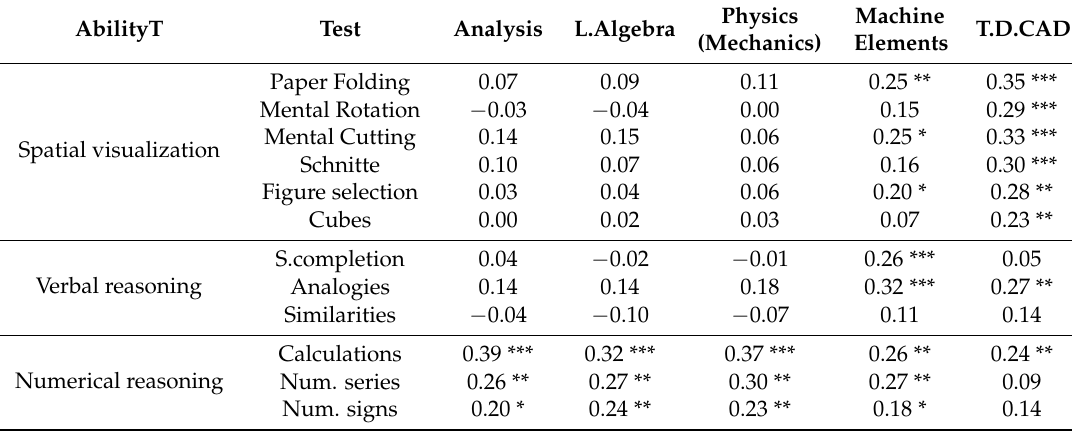
Table 5. Correlations between ability measures and grades among engineering students ( N = 150). AbilityT Test